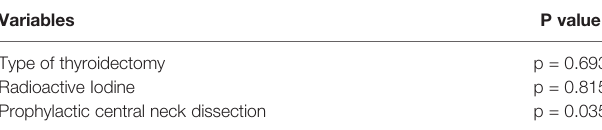
TABLE 4 | Multivariate analysis of risk factors for recurrence in pediatric